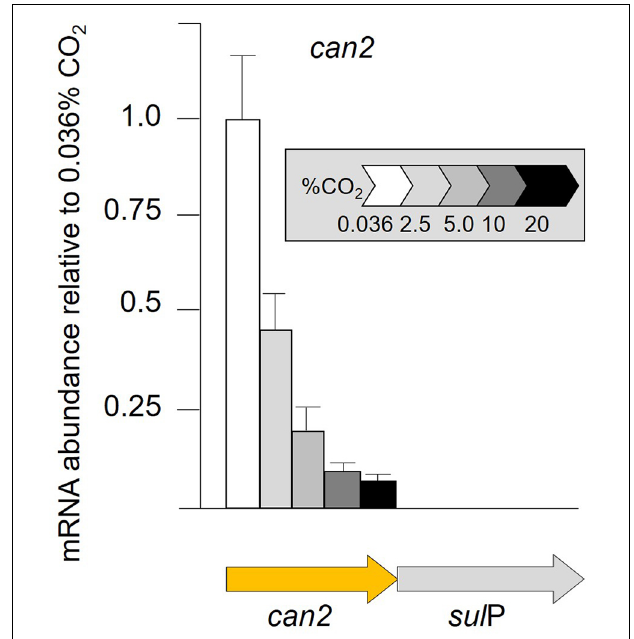
FIGURE 5 | RNA transcript abundance (assayed by RT-qPCR) of can 2 when cells were grown in different concentrations of CO 2 from 0.036% CO 2 (air) to 20% CO 2 . Orange arrow indicates the gene assayed for transcript